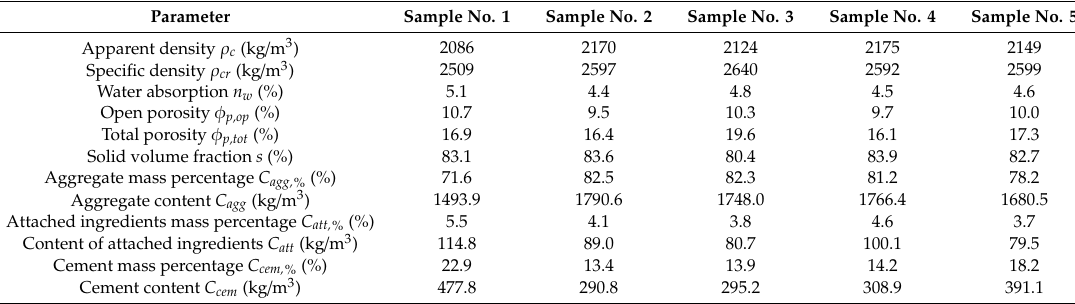
Table 2. Test results and calculations for individual samples 1–4 and average sample 5 (Figure